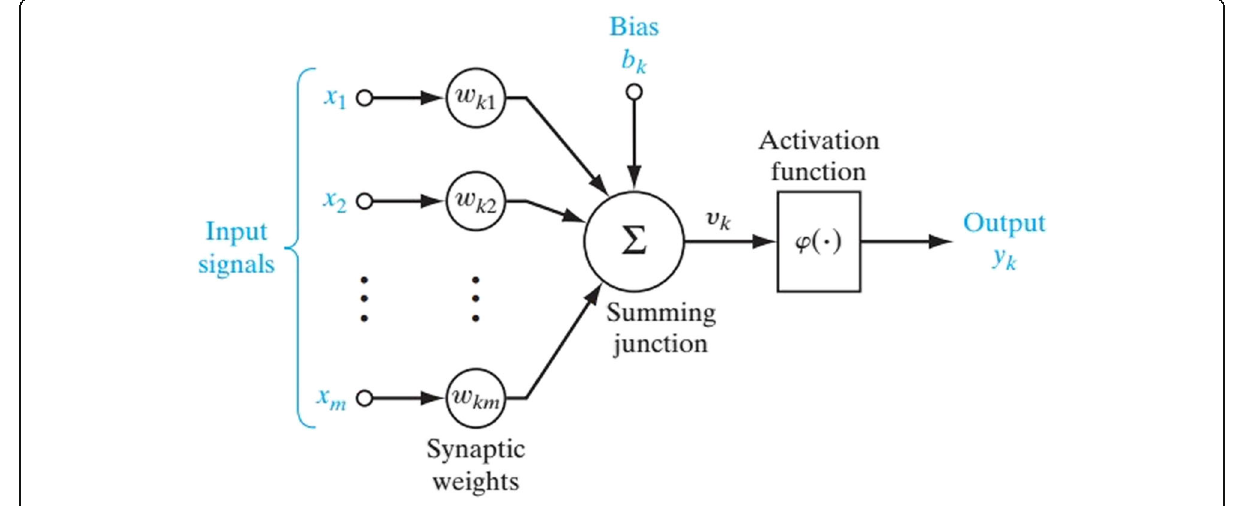
Fig. 1 A single layer neural network